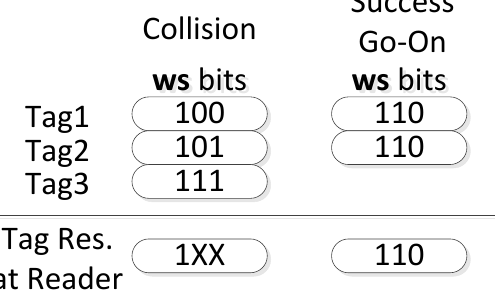
Figure 5. Slot statuses of the bit-tracking combined with the window ( ws = 3